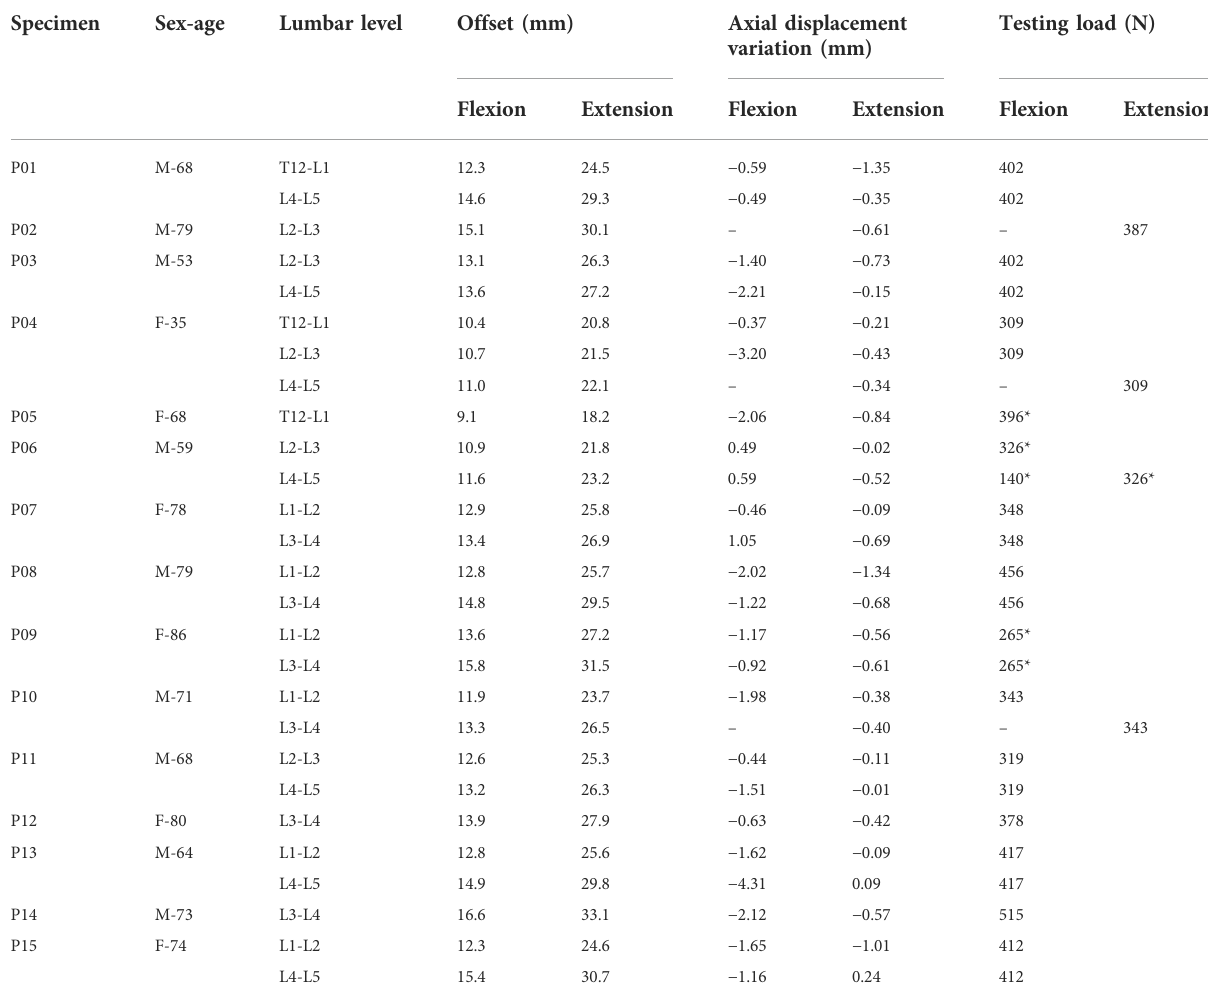
TABLE 1 Donors ’ data and testing parameters for fl exion and extension.